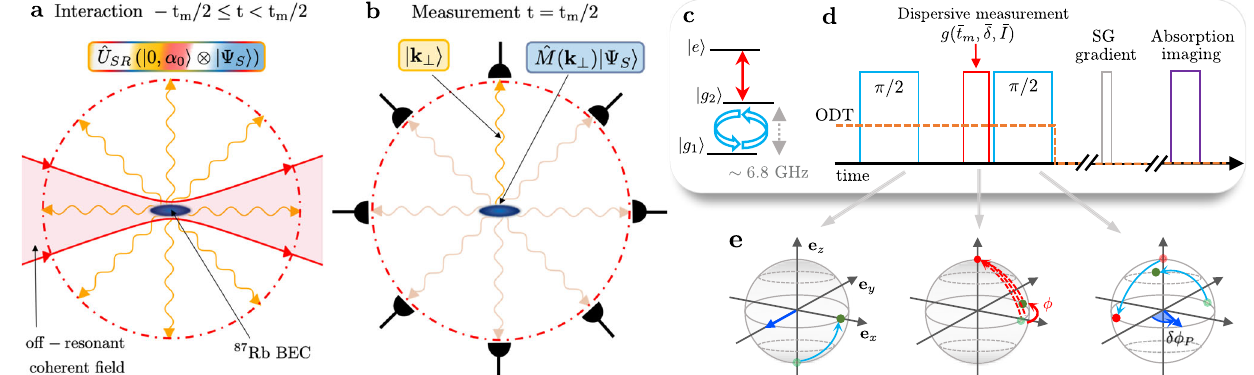
Fig. 1 Photodetection measurement model and Ramsey interferometry. a Interaction. A Bose-Einstein condensate (BEC) illustrated in blue, is illuminated with far-detuned laser light (red) for a time t m and scatters light (wiggly lines) into both occupied (red) and reservoir (orange) modes. b Measurement. The reservoir modes are projectively measured by an array of photo-detectors encompassing 4 π steradians yielding the outgoing wavevector and polarization. c Level diagram. d Time sequence for Ramsey interferometry. An initial π /2 microwave pulse (light blue) is followed by a 15 μ s evolution period; then the t m = 20 μ s off-resonant light pulse (red) is applied, and after a 5 μ s delay (giving a total T = 40 μ s free evolution time) the Ramsey sequence is completed with a second π /2 pulse (light blue). The optical dipole trap (ODT), denoted by the orange dashed line, is extinguished immediately following the Ramsey sequence. A Stern-Gerlach (SG) gradient (gray) is applied during time-of- fl ight (TOF) and the fi nal density is detected using absorption imaging (purple). e Bloch sphere depiction of Ramsey interferometry. The dark blue arrows depict the axes of rotation for each microwave pulse and the light blue arrows mark the associated trajectories. The green circles show the coherent evolution during each step of our sequence. Red arrows depict evolution associated with the measurement pulse with the solid curve resulting from the Stark shift and dashed curves resulting from measurement back-action. The red circles are the states that were measured to be in |g 2 〉 . Translucent (solid) symbols indicate the initial ( fi nal)